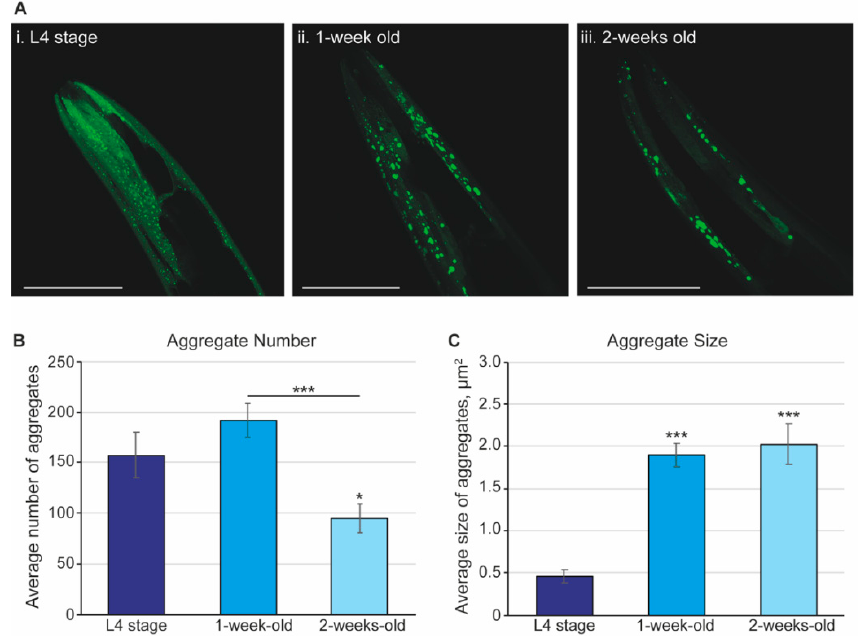
Figure 1. The α -synuclein aggregates display dynamic changes in size and number across the lifespan of C. elegans . ( A ) Representative images of the α -synuclein aggregates. Images are maximal